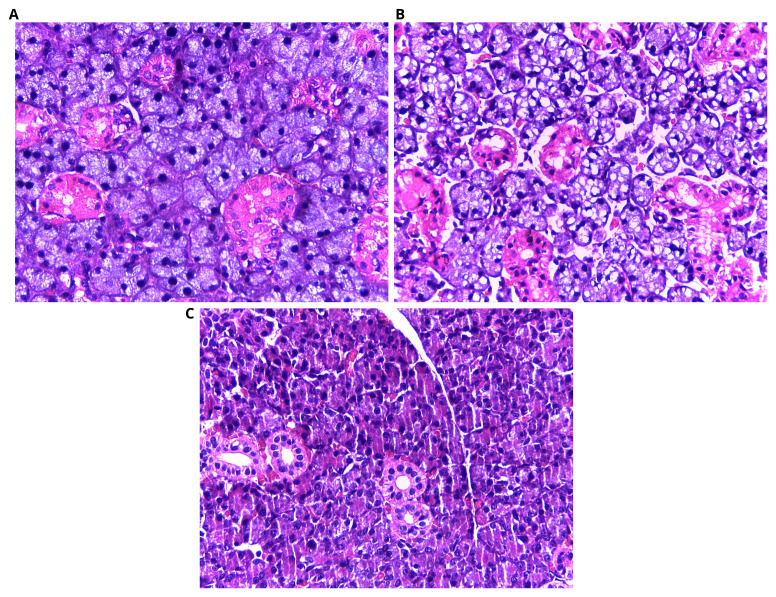
Photomicrographs showing histology of salivary glands.(
A) Control group, regular gland architecture; (
B) DXR group, degenerated acini with multiple vacuoles extravasated red blood cells (RBCs) in between acini and ducts; (
C) DXR+EGF group, well aligned acini together with blood vessels engorged with RBCs in association with the striated ducts exhibiting good cell alignment and minute areas of small vesicles. H&E staining, orig. mag. X400.